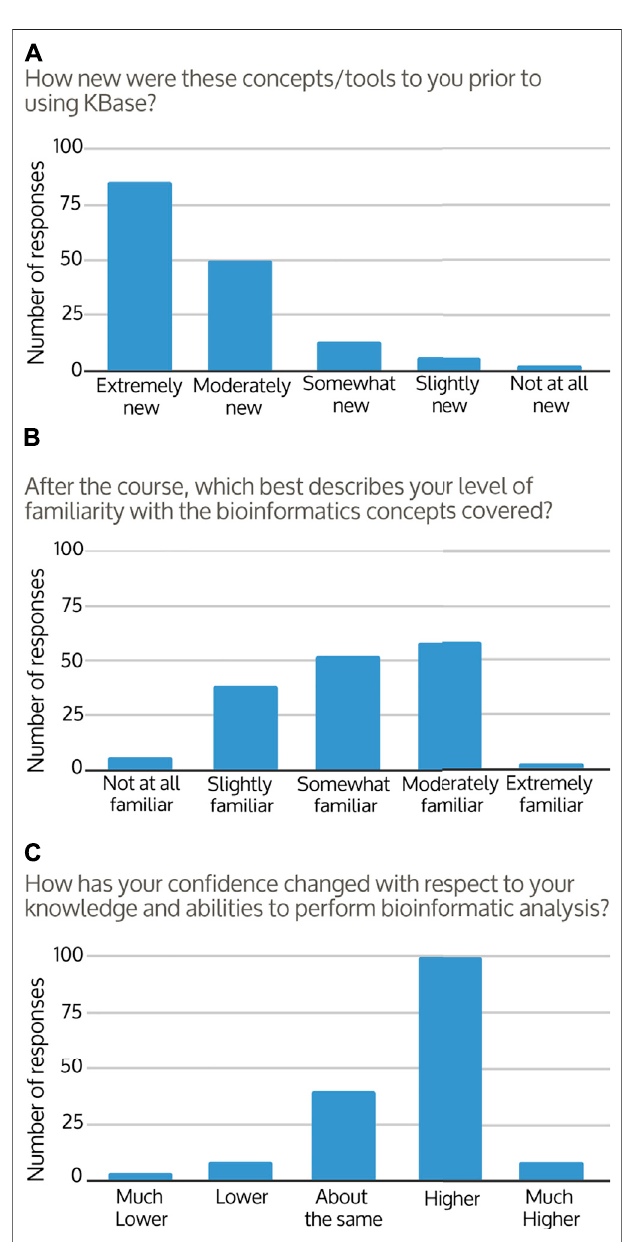
FIGURE 3 | Frequency distributions of student responses to survey questions comparing (A) pre-course to (B) post-course knowledge and (C) self-assessed con fi dence. There were 155 – 157 responses per question as each question was optional for students to answer.